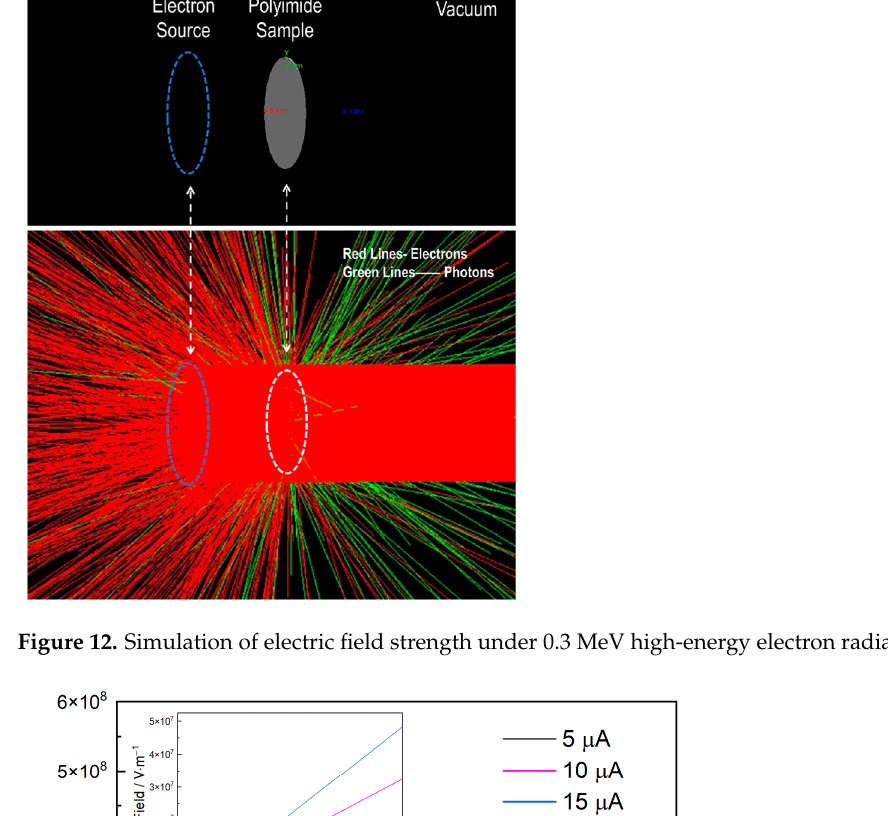
Figure 13. Simulation results of the maximum electric field under the radiation of three electron beam currents at 0.3 MeV.